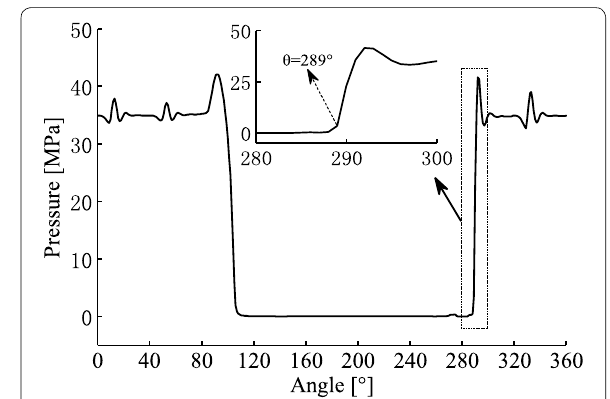
Figure 12 Pressure change in the piston chamber